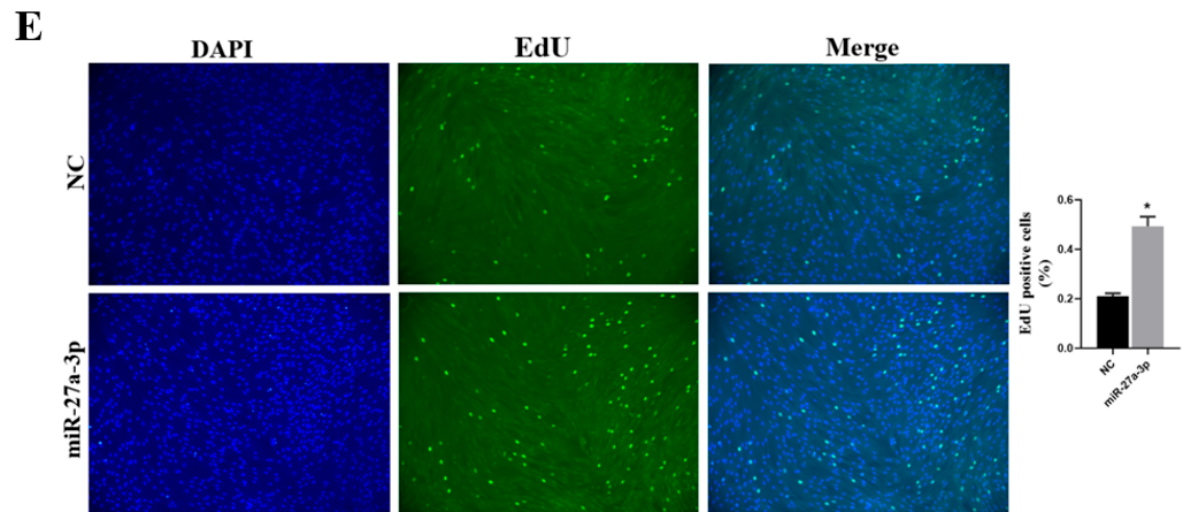
Figure 3. Overexpression of miR-27a-3p increases proliferation and reduces SMSCs differentiation. ( A ) qRT-PCR analysis to determine the expression of miR-27a-3p in SMSCs. ( B ) qRT-PCR analysis to determine the expression level of MyoD in SMSCs after transfecting with miR-27a-3p mimic. ( C ) The protein level of MyoD was analyzed by Western blotting after overexpression of miR-27a-3p mimic in SMSCs. ( D ) Representative immunofluorescence images of SMSCs after transfected with miR-27a-3p mimic and (or) NC and maintained in differentiating for 48 h. ( E ) Cell proliferation was detected with 5-ethynyl-20-deoxyuridine (EdU) and the proliferation rate was represented by the percentage of EdU positive cells. The number of ‘’*” indicates the level of significance (***, p < 0.001, **, p < 0.01, *, p < 0.05). The p values were analyzed by Student’s t -test; p <